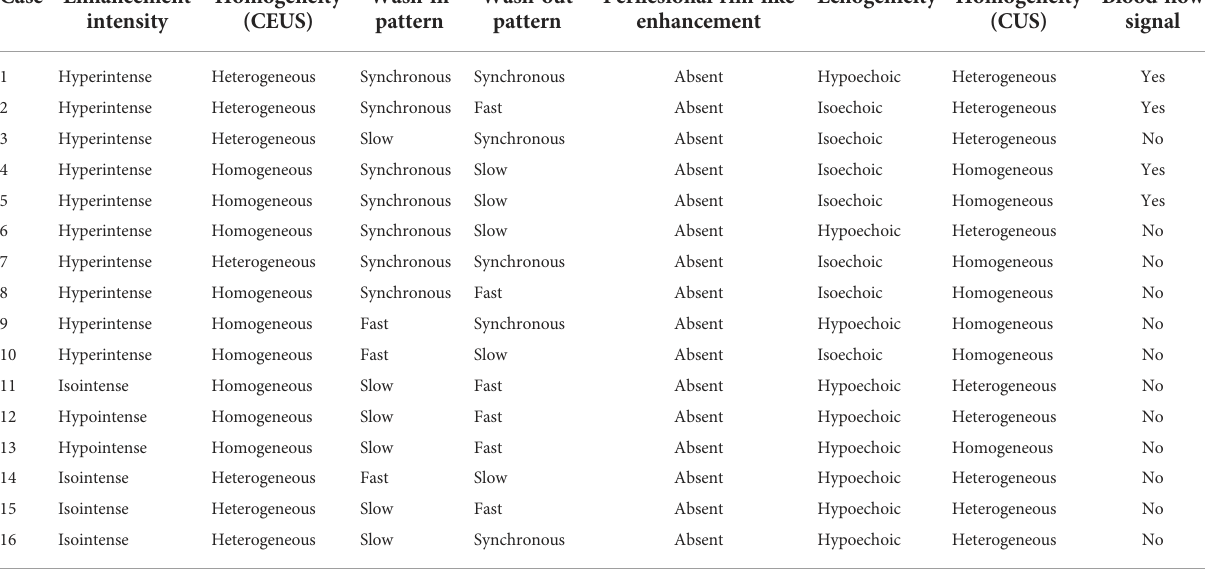
TABLE 2 CEUS and CUS characteristics of the 16 renal